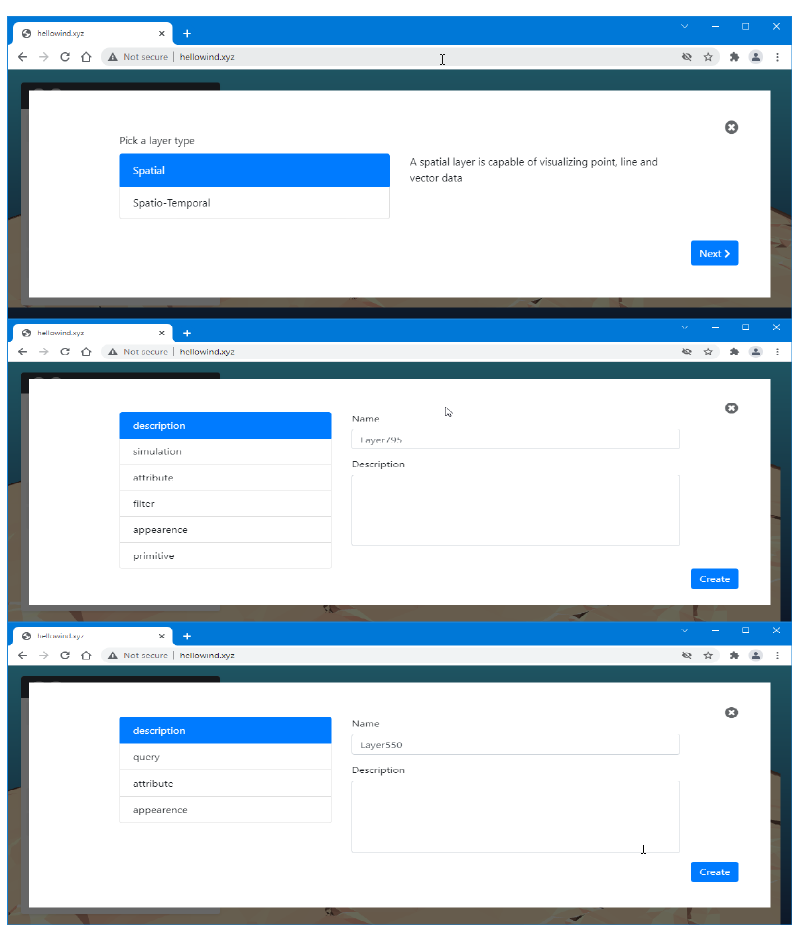
Figure 13. From top to bottom: The layer editor wizard, the layer settings for a spatial layer, and the layer settings for a spatio-temporal layer.